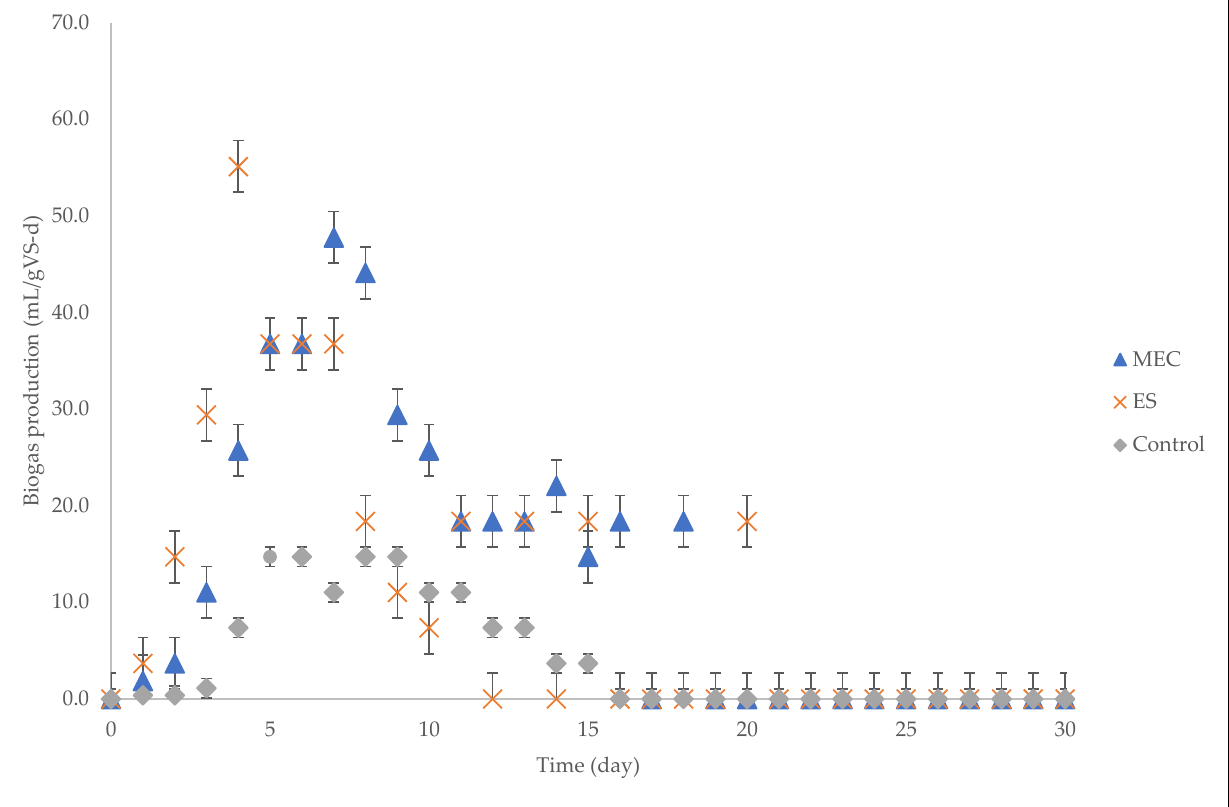
Table 1. Methane content and methane yield.